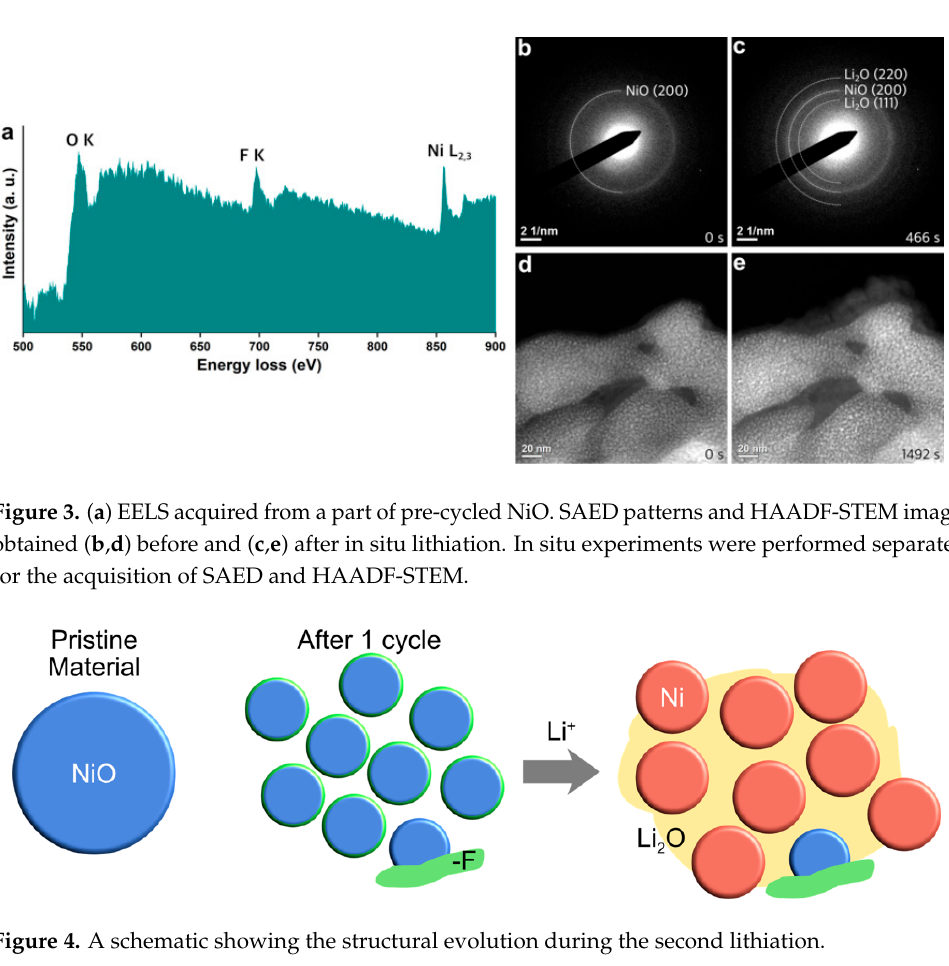
Figure 4. A schematic showing the structural evolution during the second lithiation.